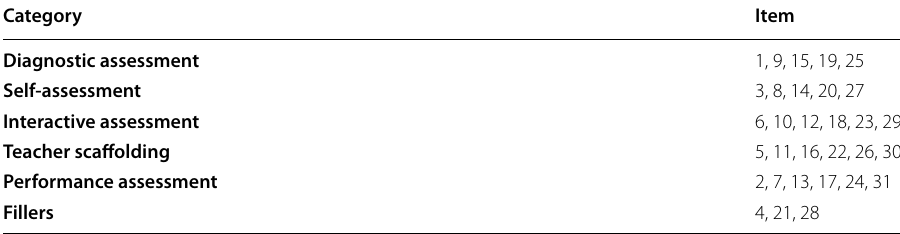
Table 2 Questionnaire